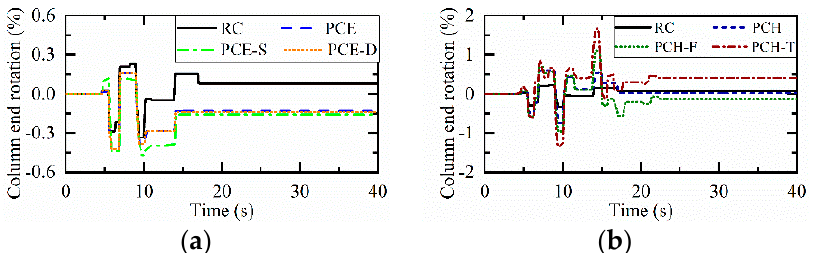
Figure 15. Time history of the rotation angle at beam end of top floor under Wave 4 (PGA: 600 gal): ( a ) Comparison between emulated frames and the RC frame; ( b ) Comparison between non-emulated frames and the RC frame.